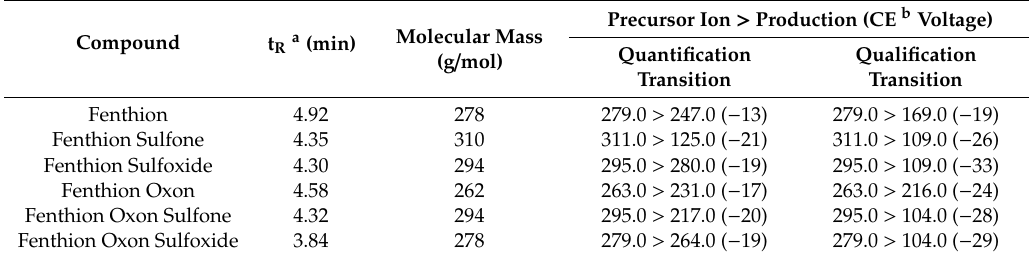
Table 1. Multiple reaction monitoring (MRM) transitions and retention times for ultra-high